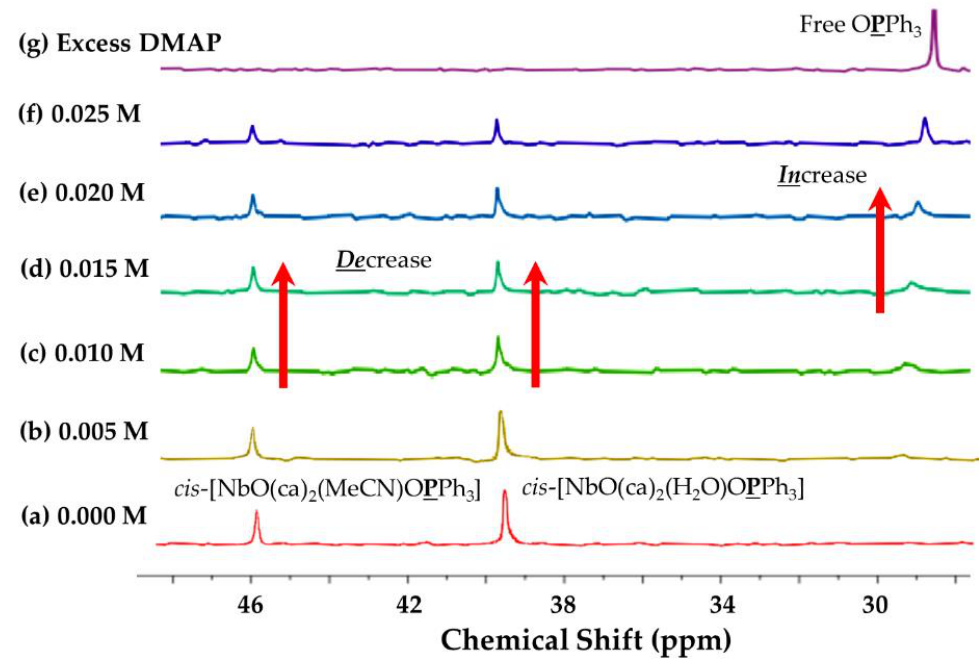
Figure 4. Illustration of 31 P{ 1 H} NMR spectral change (after equilibrium has been reached) for the substitution of triphenylphosphine oxide from cis -[NbO(ca) 2 (H 2 O)OPPh 3 ] − (0.013 M) ( a ) by DMAP (0.005–0.03 M) ( b – g ). Illustrated is the decrease in both the cis -[NbO(ca) 2 (MeCN)OPPh 3 ] − and the cis -[NbO(ca) 2 (H 2 O)OPPh 3 ] − , accompanied by the increasing liberated free OPPh 3 product the signal at 29.6 ppm, at 25 °C in CD 3 CN. Time allowed after each addition = 30 min.